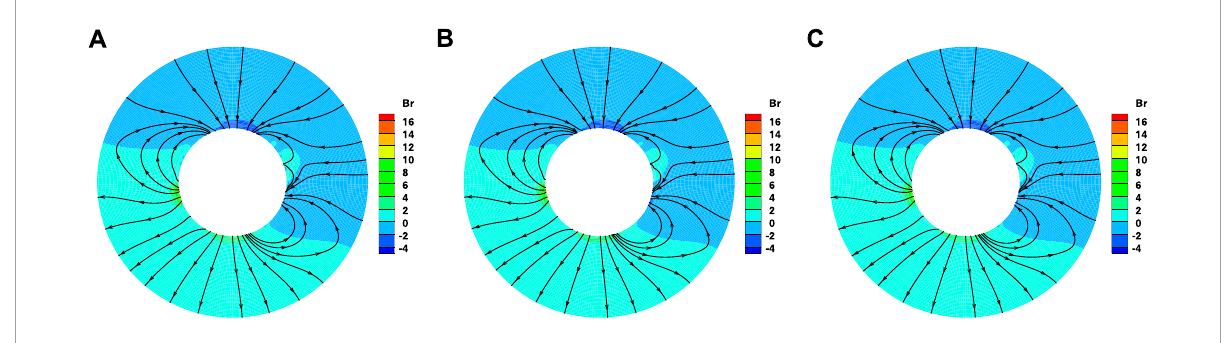
FIGURE 4 Topologies of the coronal magnetic fields on the meridional plane of ϕ = 180 °− 0 ° from 1 R s to 2 . 5 R s , obtained with (A) the SHE solver, (B) FDIPS, and (C) the DDG-PFSS solver. In order to make direct comparisons between these two numerical methods, the starting points at 1 R s of the magnetic fields are the same.